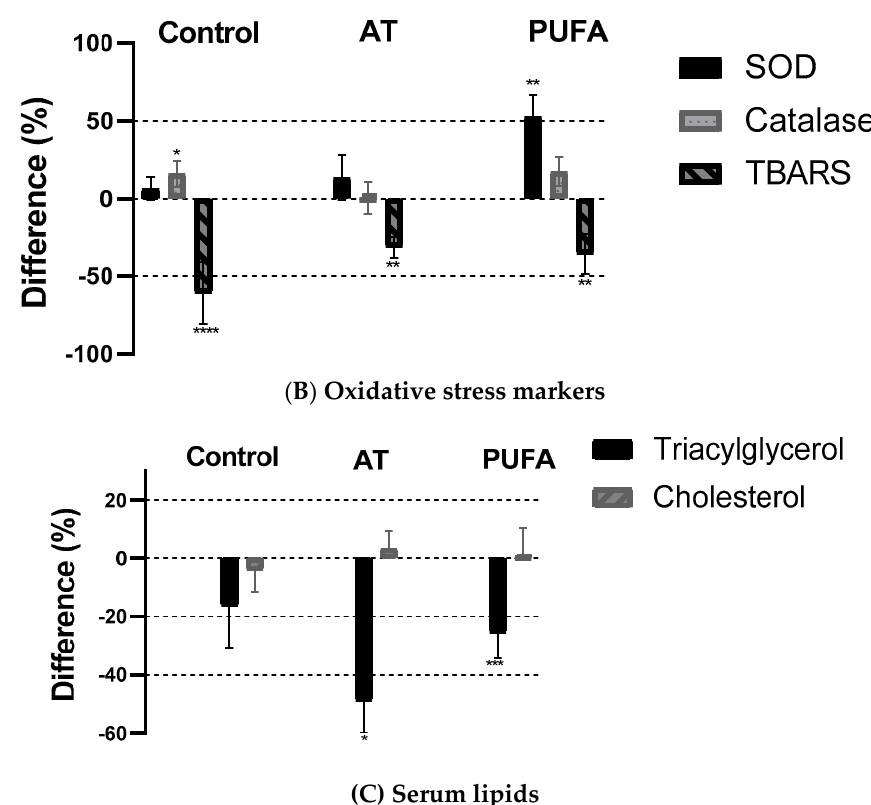
Figure 2. Effect of phytic acid on iron indices ( A ), oxidative stress indices ( B ), and serum lipids ( C ) fed in ß2m KO mice fed basal, AT, and PUFA diets with and without phytic acid. Each bar represents the di ff erence (%) in value within each group ( + PA / − PA * 100). The di ff erences between with and without PA for each diet were tested using a t-test. (* p ≤ 0.05; ** p ≤ 0.01; *** p ≤ 0.001; **** p ≤ 0.001). AT, atherogenic; PUFA, polyunsaturated fatty acid; PA, phytic acid; TBARS, thiobarbituric acid-reactive